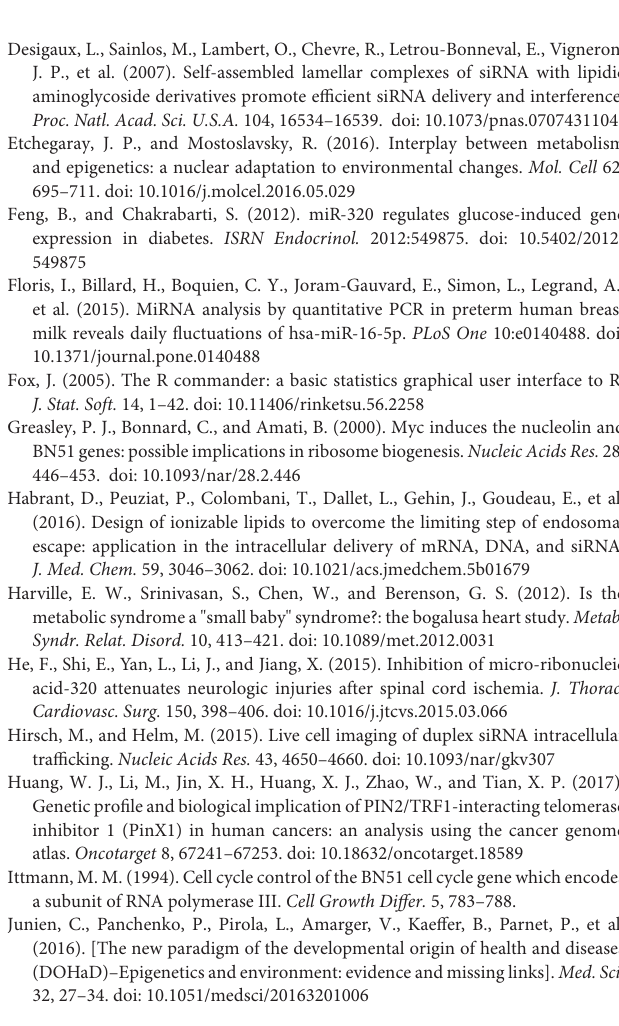
TABLE S3 | Raw data corresponding to the expression of polr3d and hspb6, target genes, in stomach and liver, of miR-320-3p in rat pups receiving per os